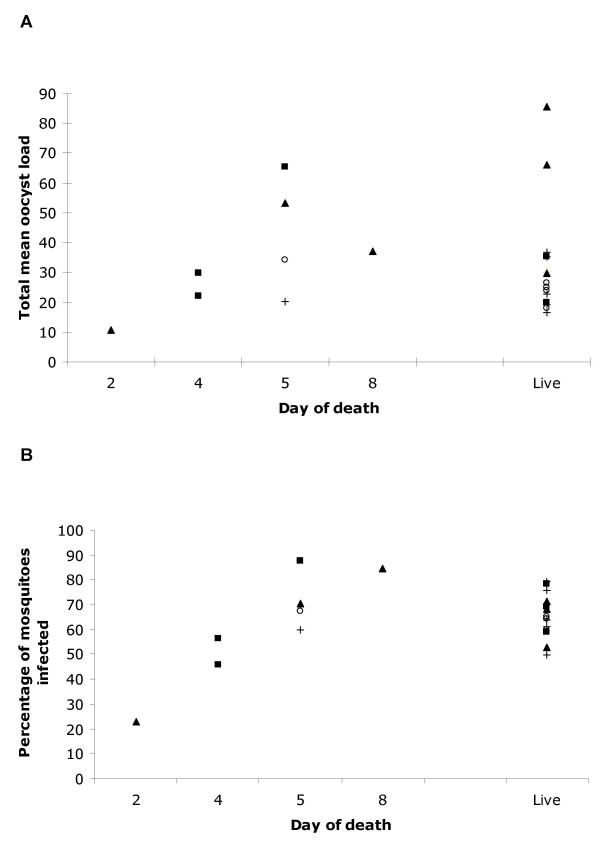
Comparison of lifetime transmission success with day of host death. Lifetime transmission success is defined as (A) the mean number of oocysts per mosquito for a given day totalled over the 4 days of acute phase transmission; (B) the percentage of mosquitoes with at least one oocyst. Infections were initiated using infectious mosquitoes as in Figs. 3 & 4. Thai or SL clone alone, 8 infective mosquitoes per bird; Mixed infections were initiated using 8 or 4 infective mosquitoes from batches of mosquitoes infected with either of the clones. Mosquitoes were gorged on all birds from the first day parasites were patent in the blood, (a) Thai clone (square); SL clone (open circles); mixed 8+8 clones (triangle); mixed 4+4 clones (crosses).